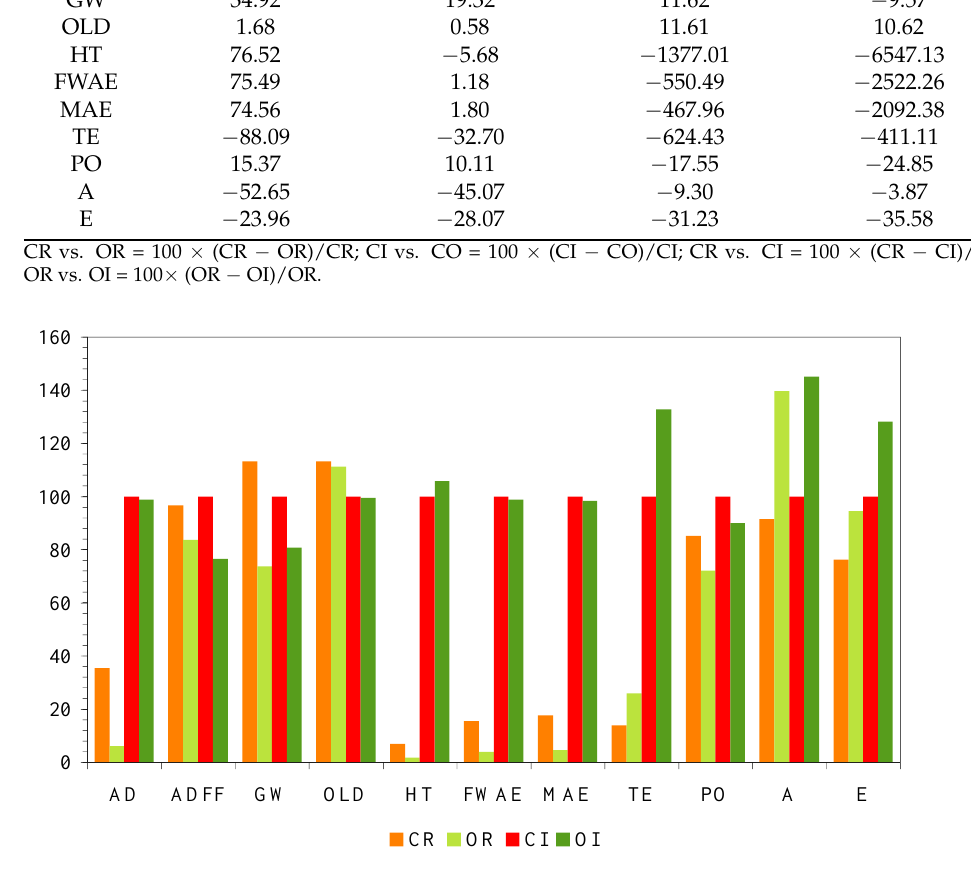
Figure 3. Differences in the potential environmental impacts for the four vineyard models in relation to CI, whose values represent 100%. Table 10. Relative differences between the different types of vineyard.